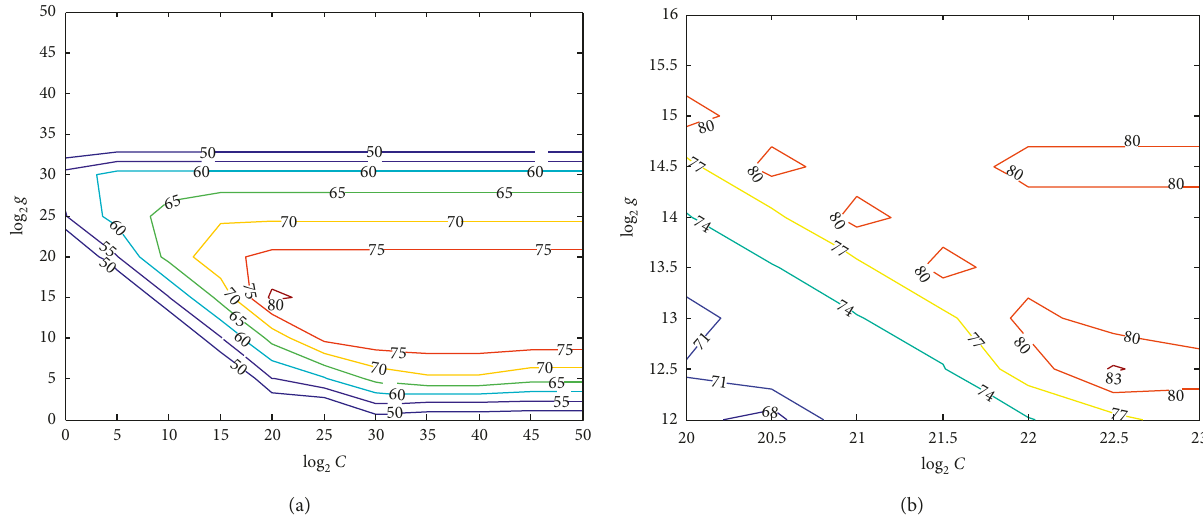
Figure 2: Optimization of internal parameters with the grid search of the PCA-SVC model. (a) Initial grid search. (b) Fine search.